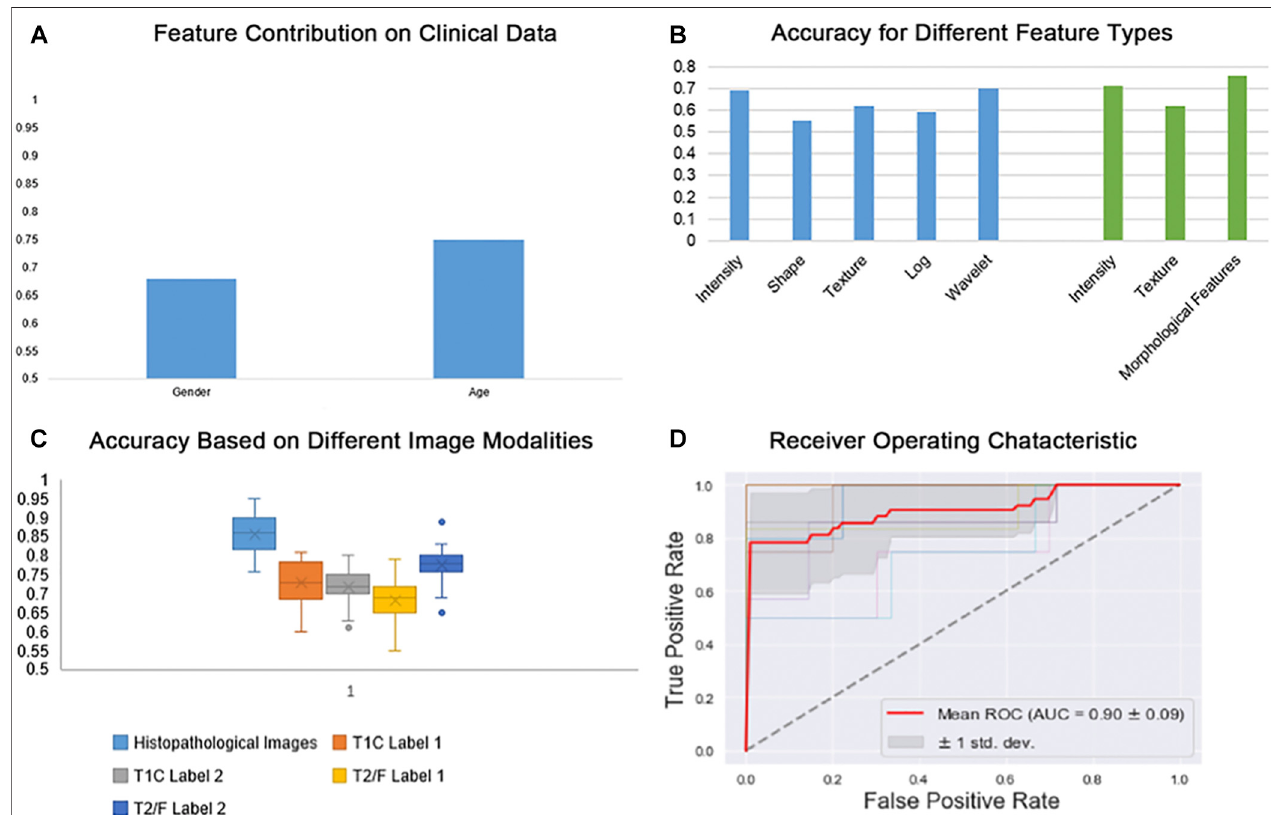
FIGURE2| Randomforestclassi fi erscoresforIDHgenotypeprediction. (A) PredictionresultsbasedonClinicaldata(ageandgender); (B) Predictionresultsbased on different feature types; (C) Prediction results based on different image modalities; (D) Receiver Operating Characteristic (ROC) for IDH genotype prediction across multi-parametric medical